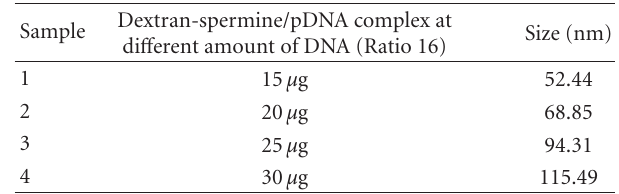
Table 1: Particle size of D-SPM/pDNA as a function of the pDNA amount loaded to D-SPM at ratio 16, determined by Nanophox particle size